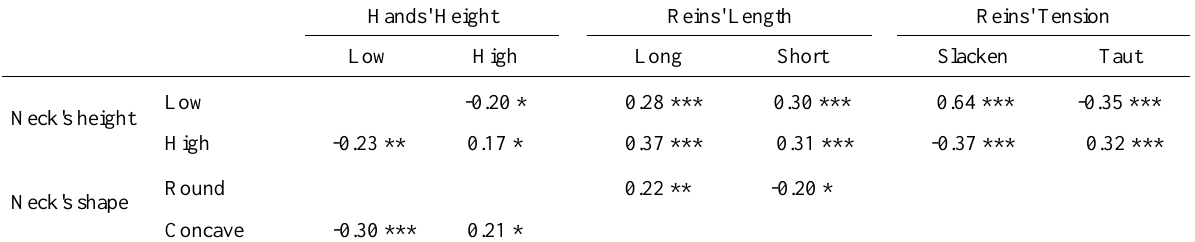
-0.30 *** 0.21 * Note. N = 142 rider-horse pairs, 17 riding schools. The table indicates the Spearman’s correlation tests’ results (r values are indicated in the